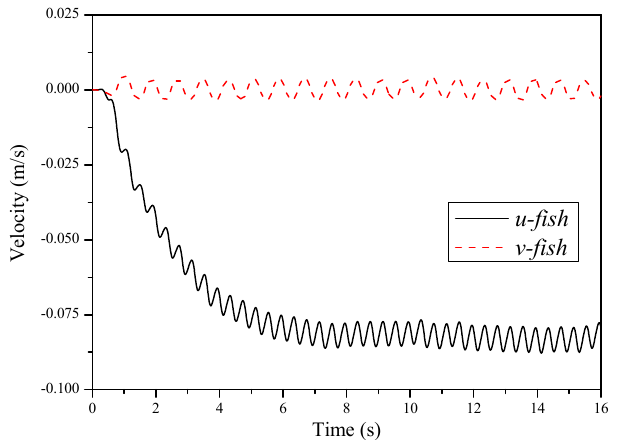
Figure 8. Velocity time-histories of the thunniform bio-inspired mode.